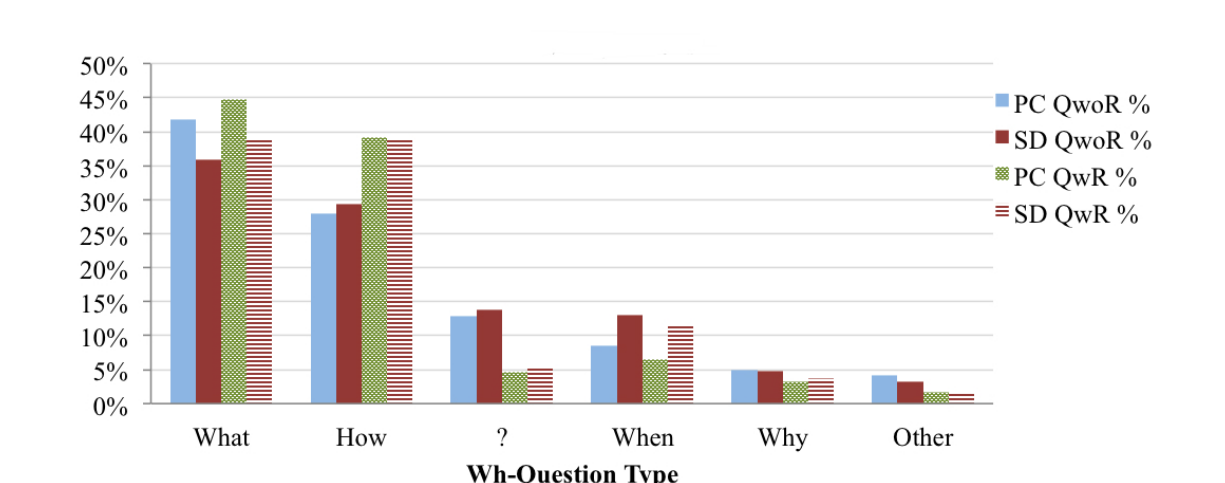
Figure 6. Distribution of the search queries based on type of